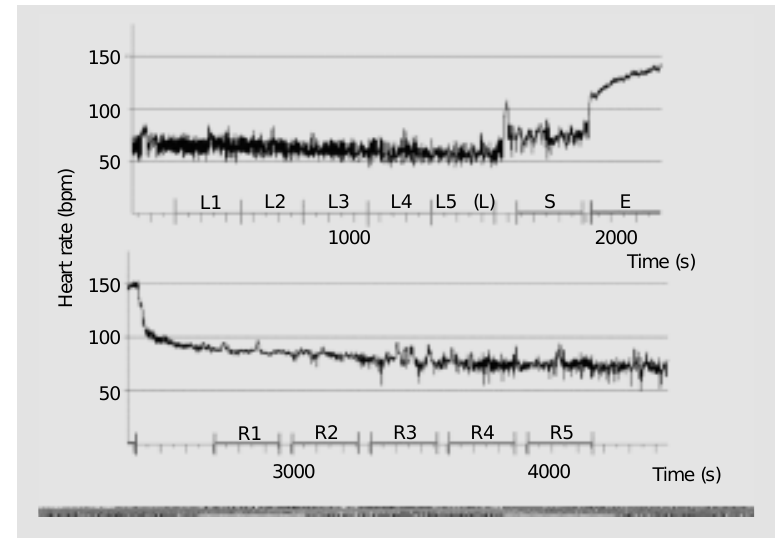
Figure 1. Original record of heart rate changes during the experiment. The segments which we analyzed are indicated (for further description, see Material and